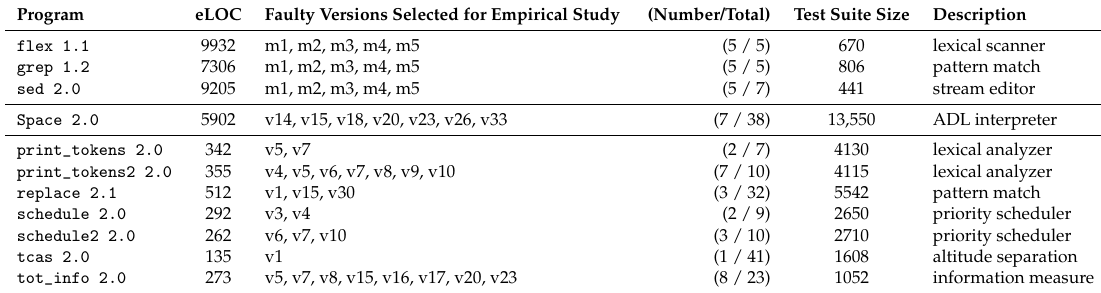
Table 2. Subject programs and test